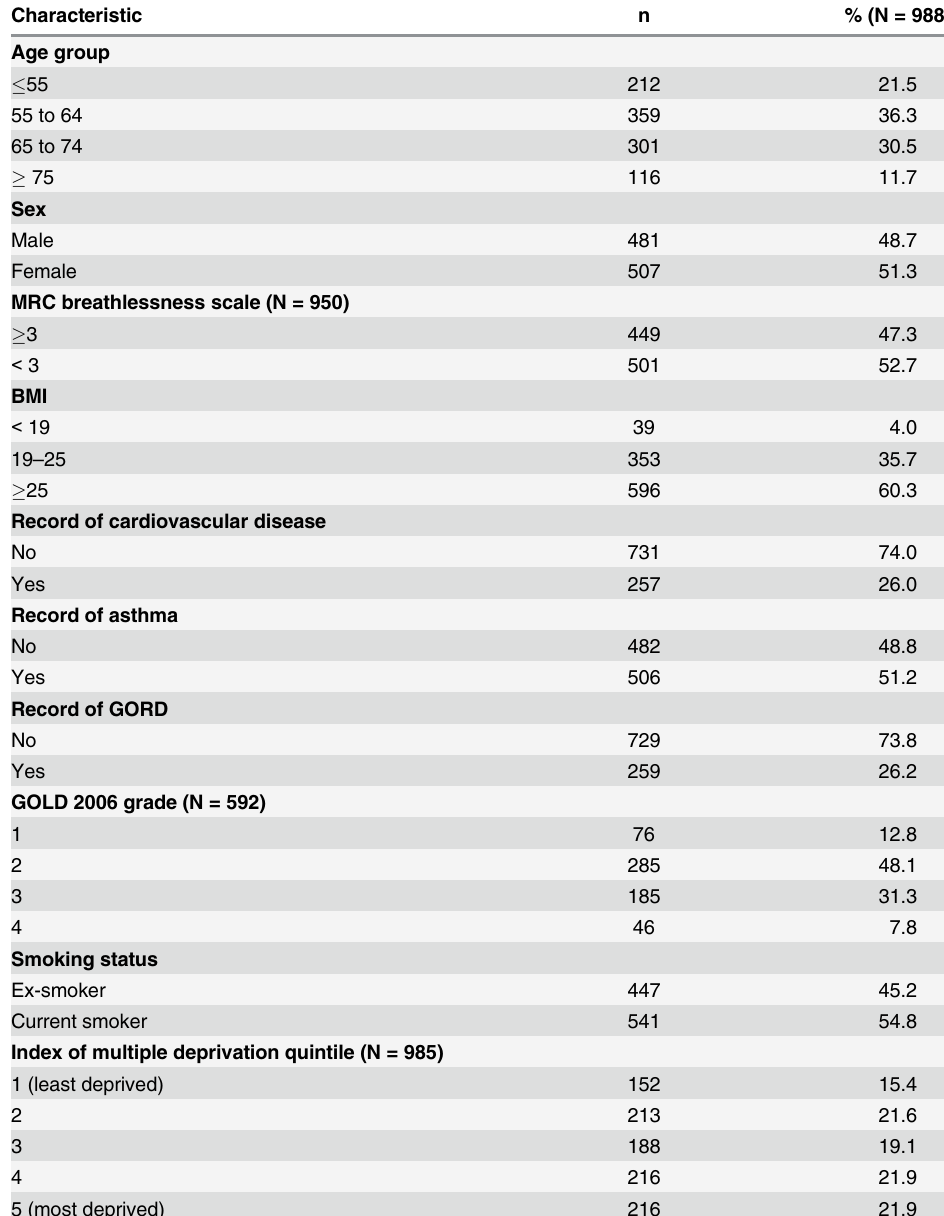
Table 2. Characteristics of the 988 patients included in the